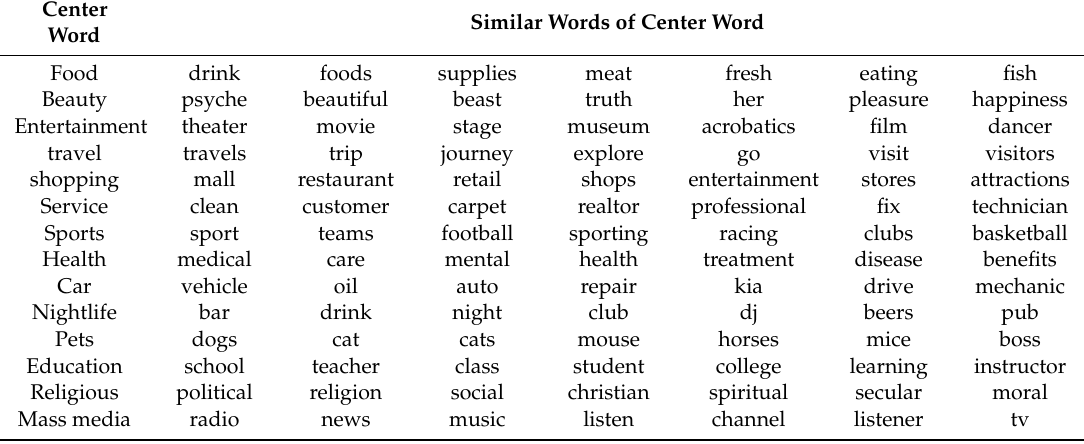
Table 9. Words that have the closest semantics with the selected words (the semantic distance is increased from left to